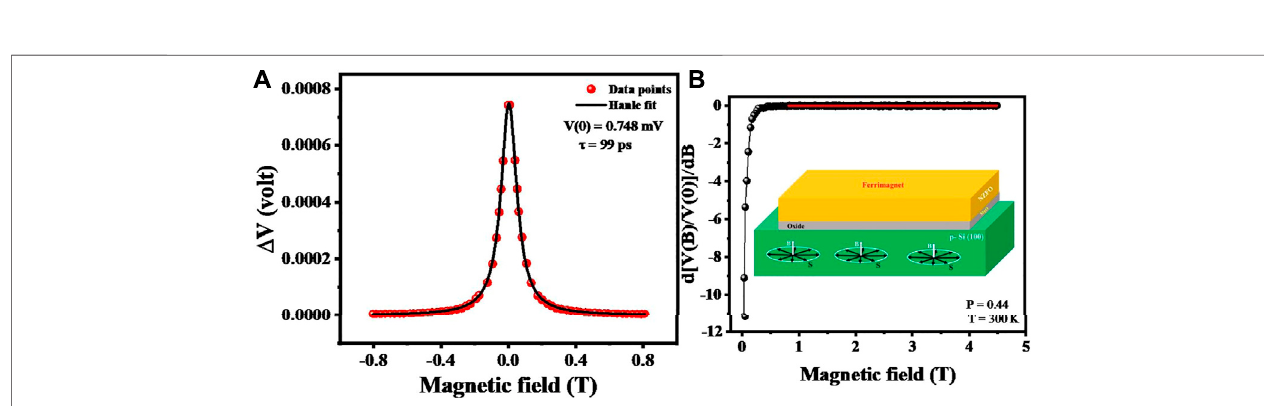
FIGURE12|(A) TheLorentzian fi toftheHanlecurveat300 Kwithabiascurrentof5 µA. (B) Thelinear fi ttothe fi rst-orderderivativeof Eq.6 togetthevalueofspin polarization. The inset shows that the perpendicular magnetic fi eld suppresses the spin accumulation in p-Si.